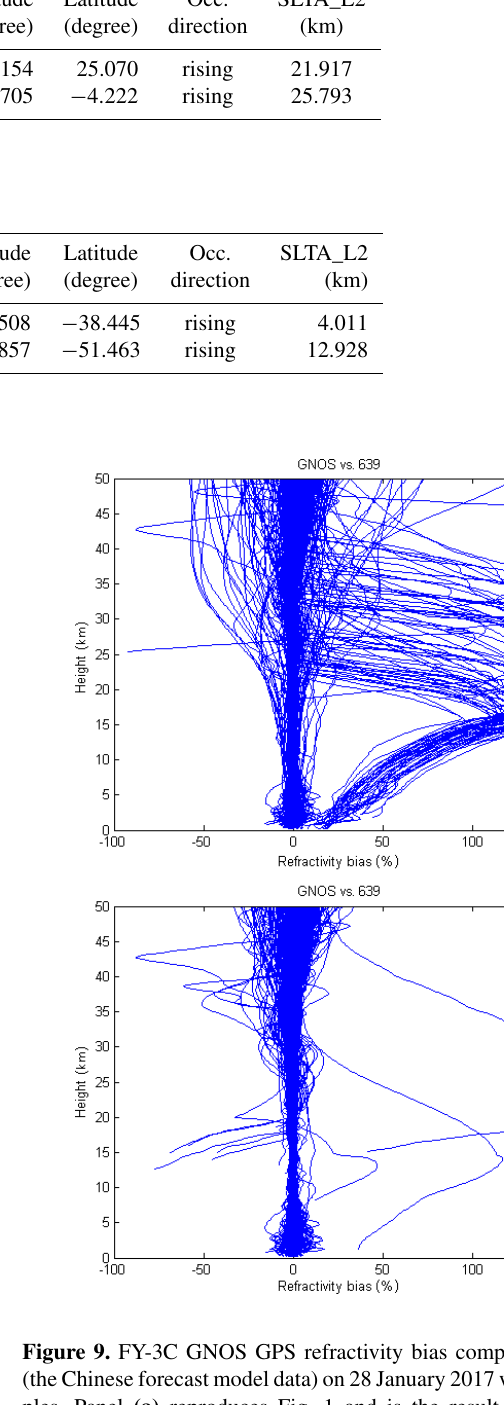
Figure 8. Good case 2 – the bending angle of L2, L1 and LC before and after correction.